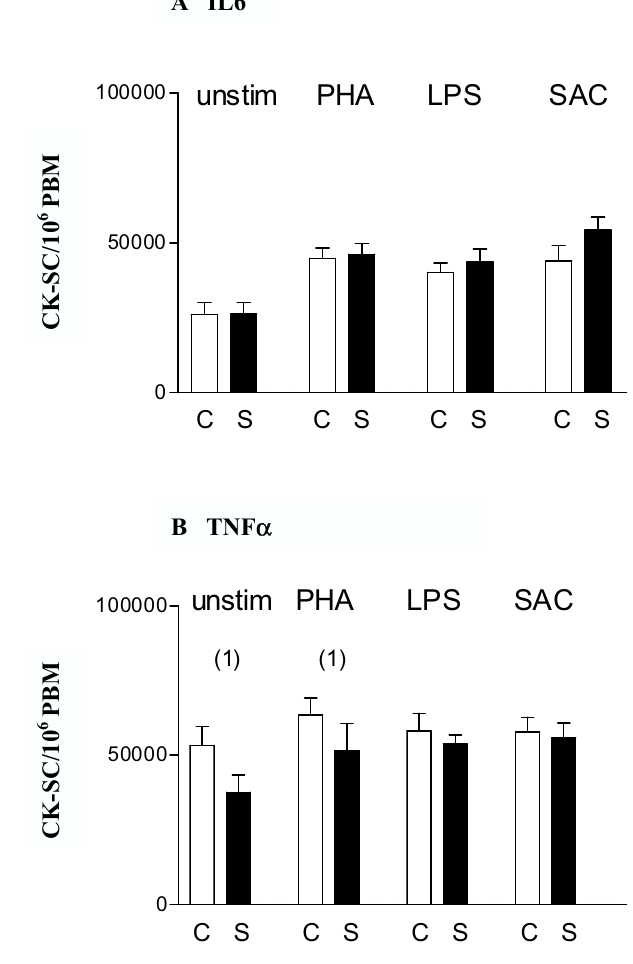
Figure 3 Numbers of IL6-SC/10 6 PBM (A) and TNF α -SC/10 6 PBM (B) at 14 weeks in subjects who continued (C) Qigong practice beyond 14 weeks and those who stopped (S) at 10